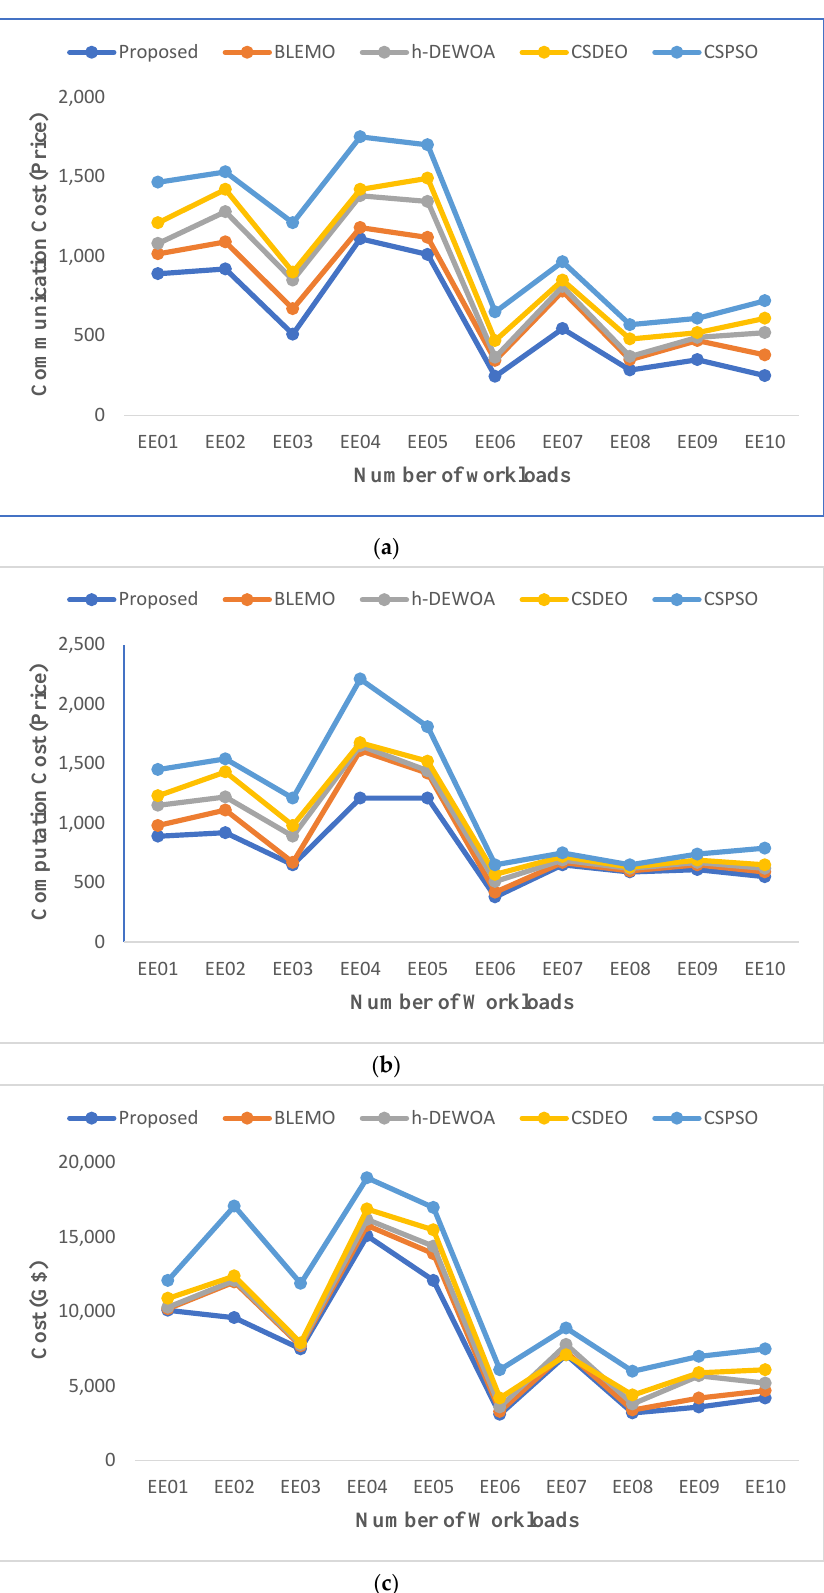
Figure 5. Comparison of ( a ) communication cost, ( b ) computation cost, and ( c ) total cost of CEA- Curie